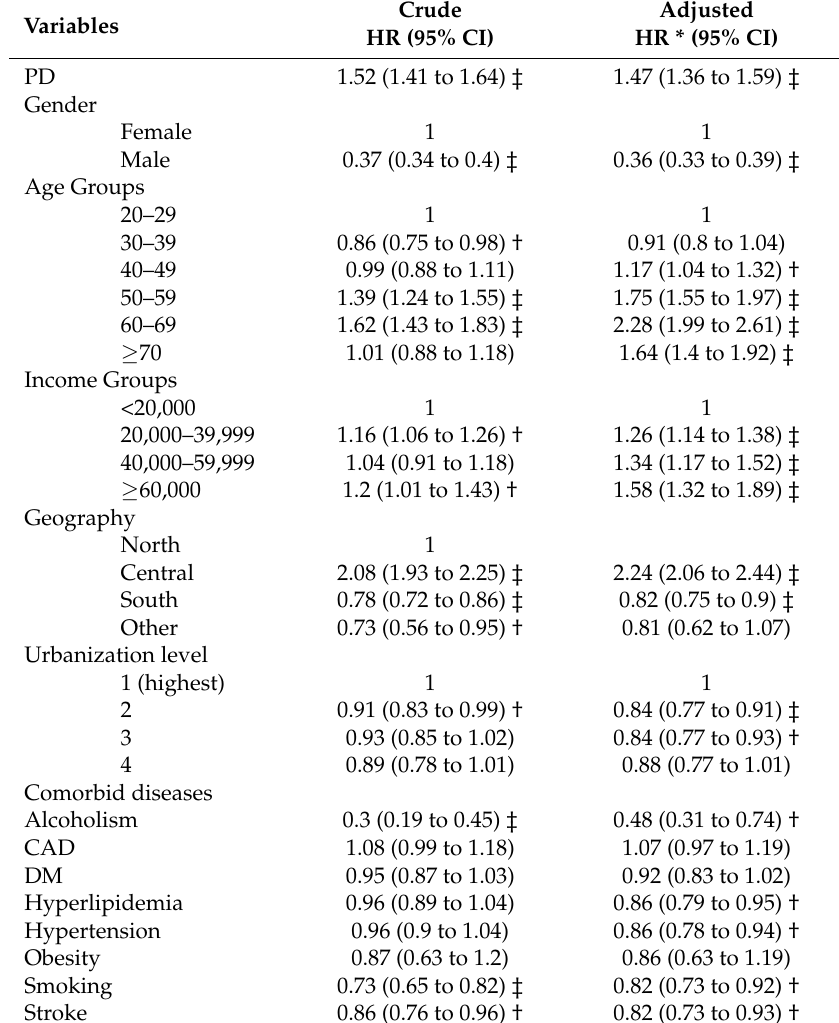
Table 3. Independent predictors of SS identified by Cox regression